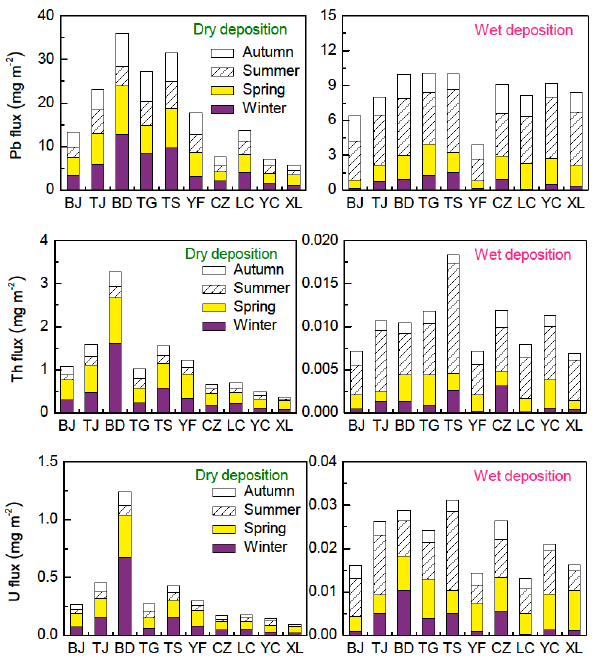
Figure 3g. Spatial distribution and seasonal variations in atmo- spheric wet and dry deposition fluxes of trace elements in Northern